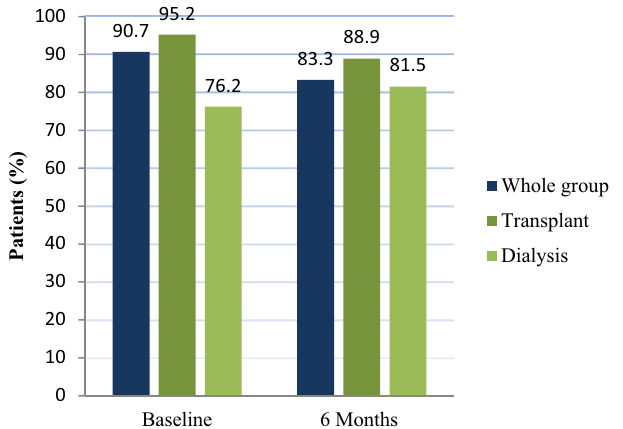
Figure 2. Frequency of gastrointestinal symptoms for the whole group and per treatment modality at baseline and 6-month follow-up (N = 76).